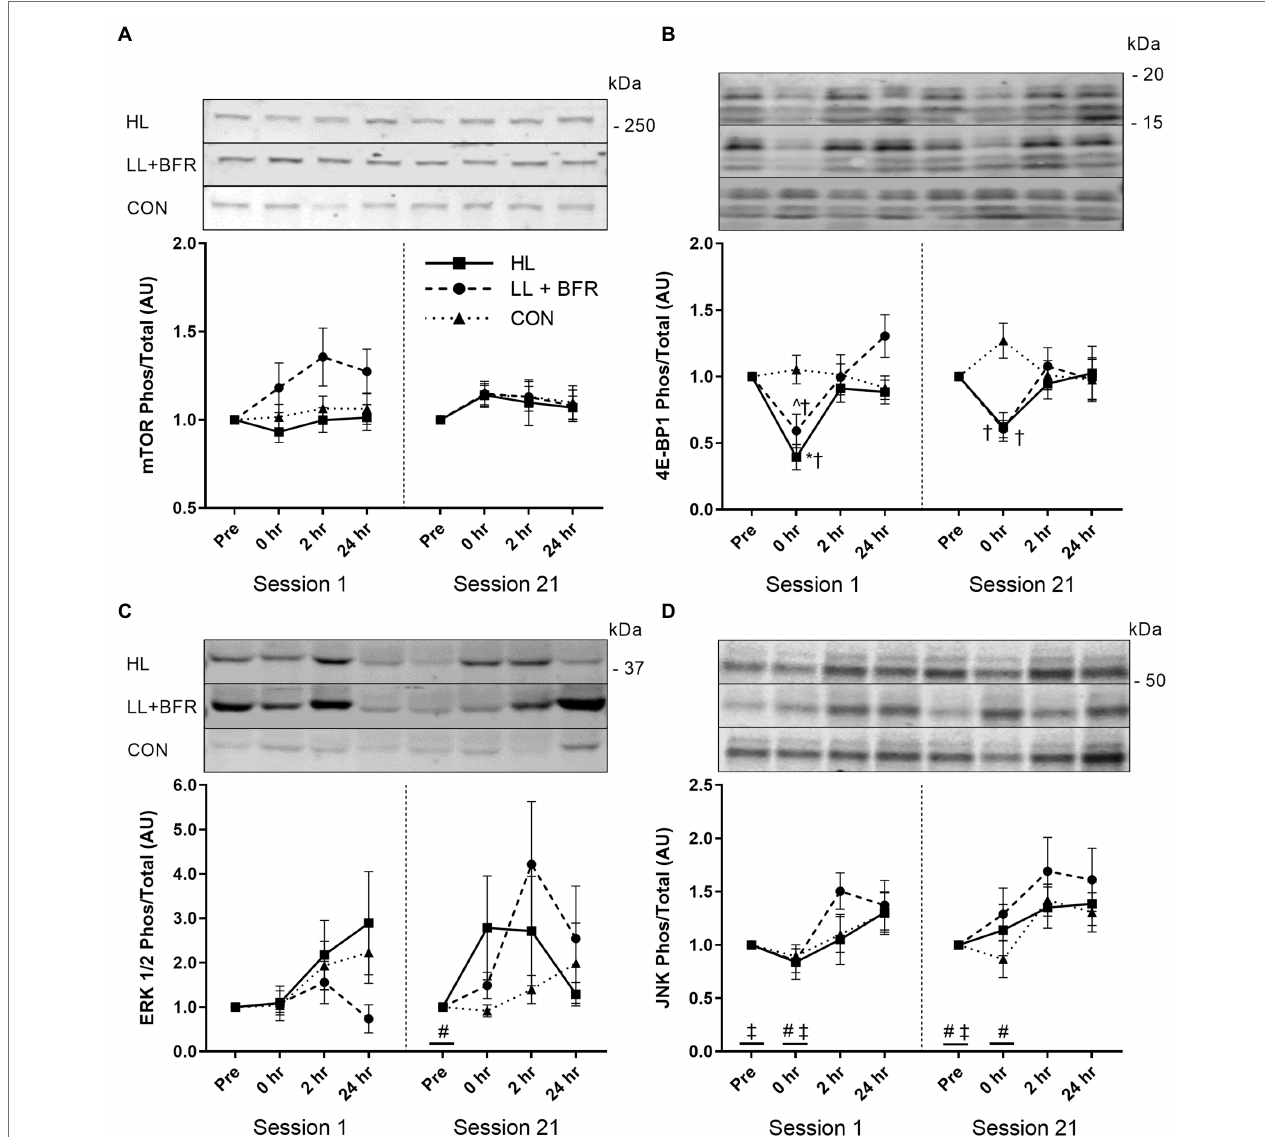
FIGURE 4 | Ratio of phosphorylated to total mTOR (Ser2448; A ), 4E-BP1 (Thr37/46; B ), ERK 1/2 (Thr202/Tyr204; C ), and JNK (Thr183/Tyr185; D ) sampled pre- exercise (Pre), immediately following (0 h), 2 h following (2 h), and 24 h following (24 h) knee extension and flexion exercise in heavy-load resistance training (HL), blood flow restriction training (LL + BFR), and non-training control (CON) groups during the first (Session 1) and last (Session 21) training sessions of a program. Representative blots also shown. Data are mean ± SEM in arbitrary units (AU; fold change). * Different from all other time points ( p < 0.05); † different from CON ( p < 0.05); ^ different from 24 h ( p < 0.01); # different from 2 h (TIME main effect; p < 0.05); and ‡ different from 24 h (TIME main effect; p < 0.05). mTOR, mammalian target of rapamycin; 4E-BP1, 4E-binding protein 1; ERK, extracellular signal-regulated kinase; and JNK, c-Jun N-terminal